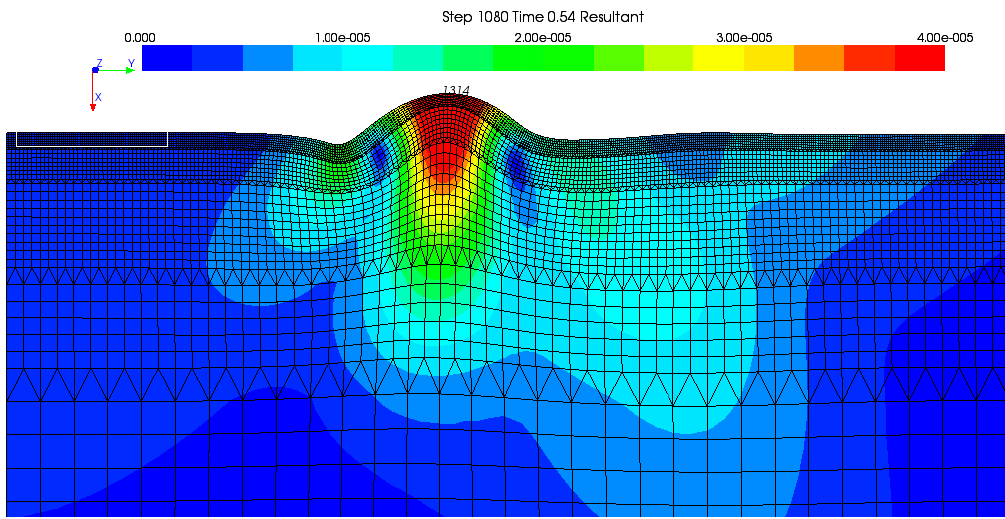
Figure 5. Model HLL1, with greater range but reduced mesh density is driven at ~5 Hz. A “hump” arrives at node 1314 at 52 m range after 0.54 s, shown as a displacement vector magnitude (low intensity becomes blue rather than green). At this moment it shows similarity to the Ricker or “Mexican hat” form.